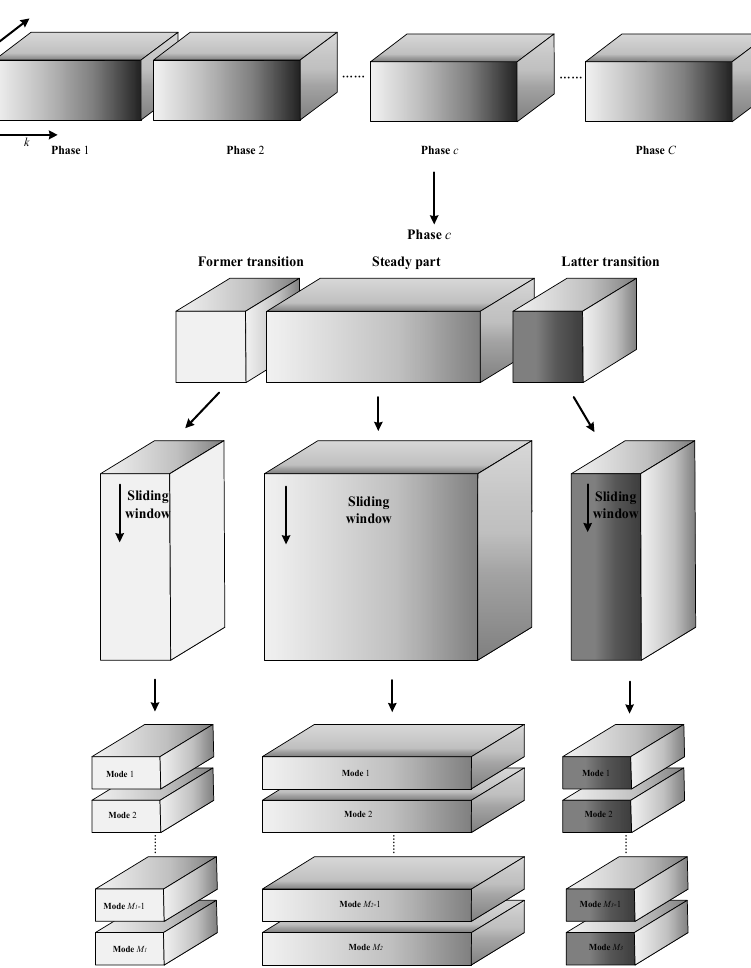
Figure 1. Schematic diagram of the overall offline monitoring model establishment .